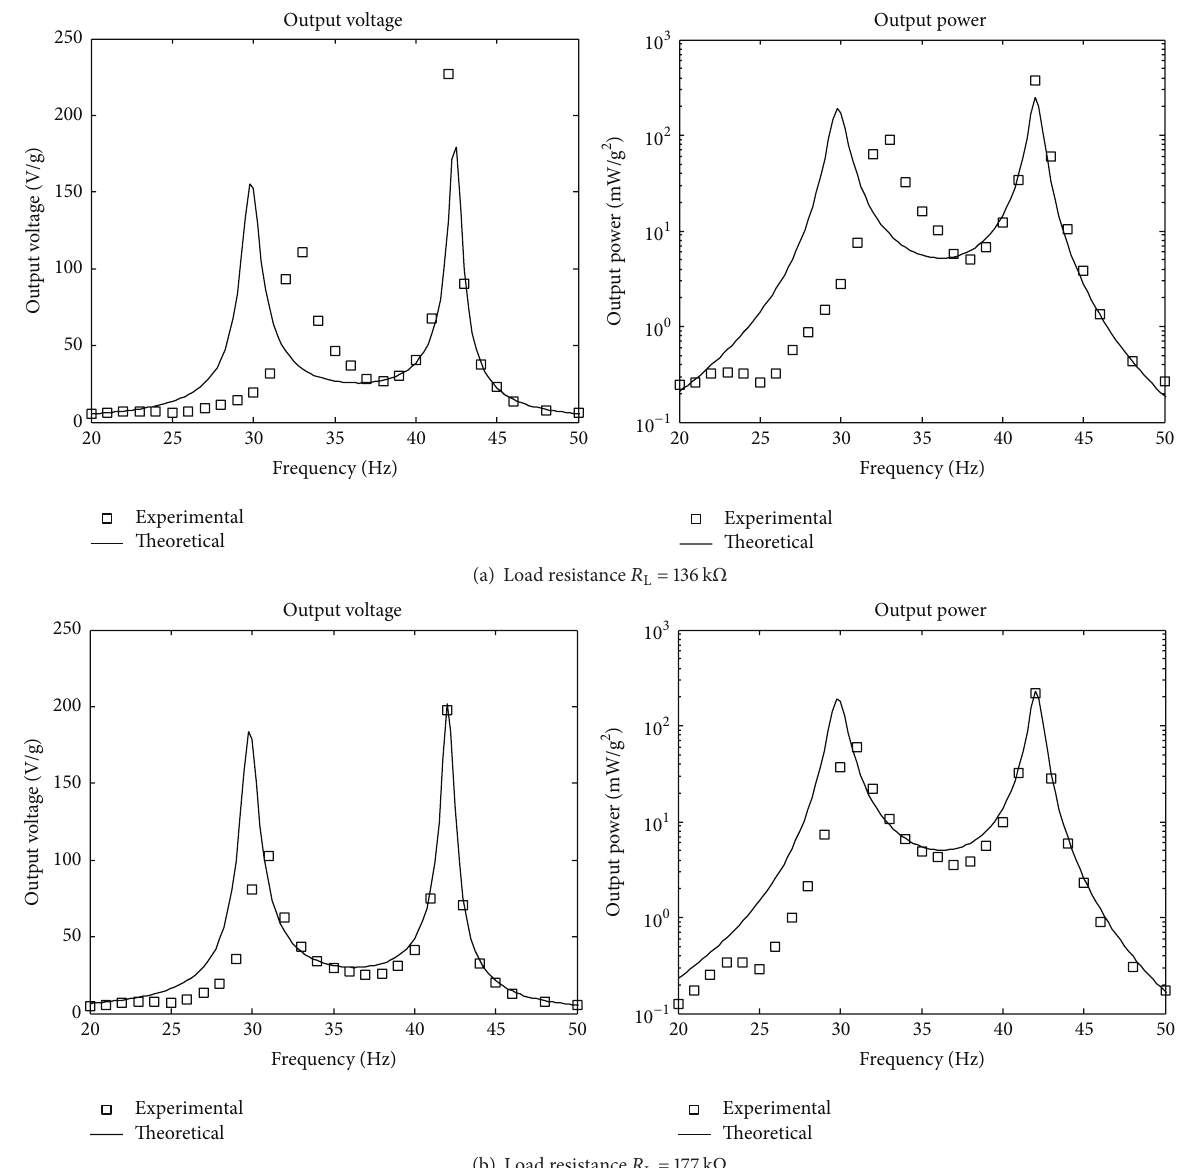
Figure 16: Frequency responses of output voltage and power of the BPEH under different load resistances when 𝑎 = 10 and 𝑟 = 15 .